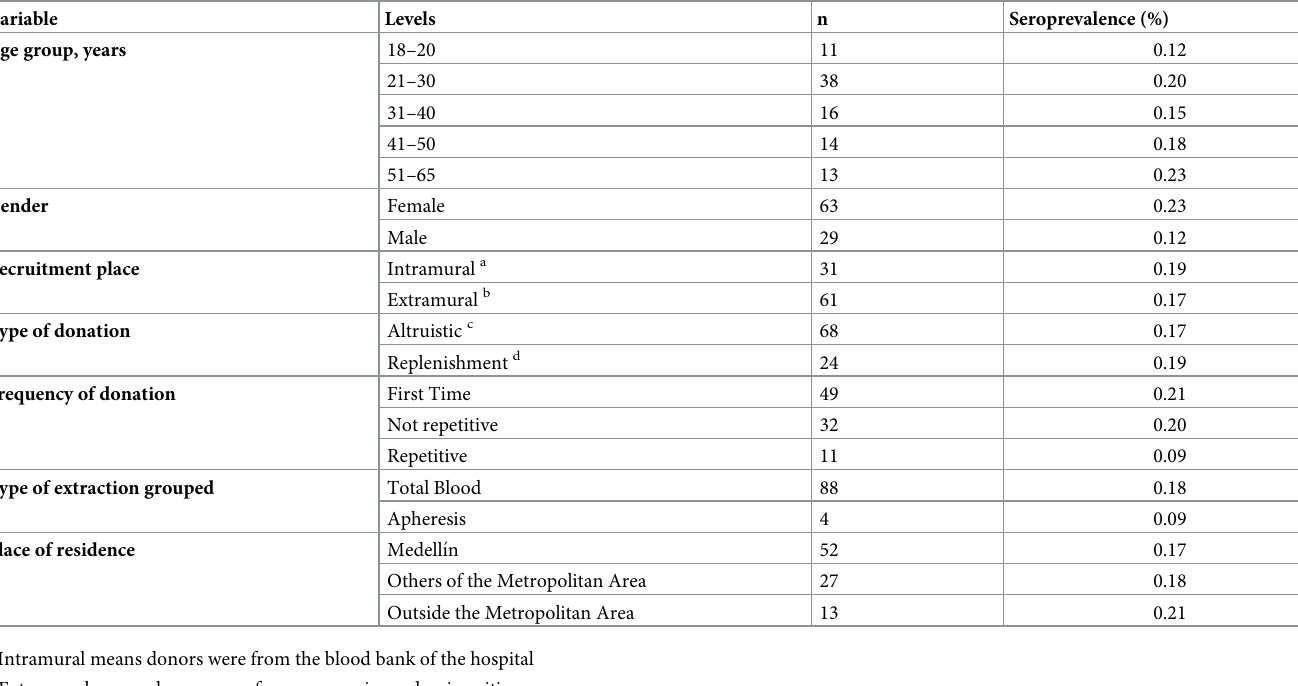
Table 2. Comparison of the specific seroprevalence of HTLV according to the characteristics of the population. Variable